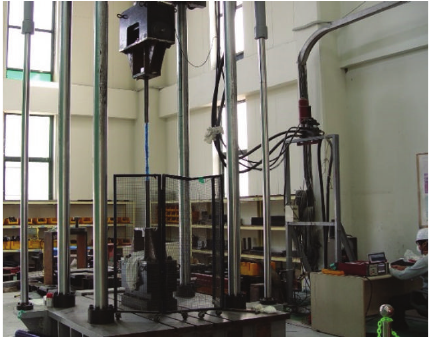
Figure 11: Tensile test